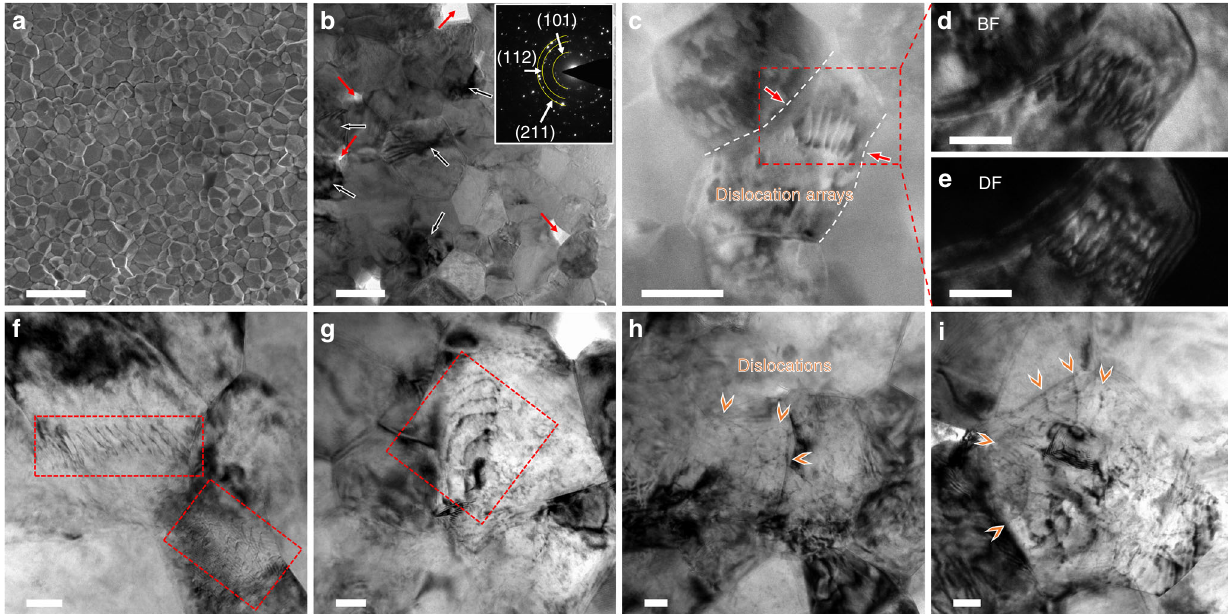
Fig. 1 Microstructure of fl ash-sintered 3YSZ. a SEM images of the unpolished fl ash-sintered 3YSZ. The average particle size is ~1 μ m. Scale bar, 3 μ m. b Bright- fi eld TEM micrograph showing subgrains with grain boundaries and defects generated during fl ash sintering (labeled by black arrows), and nanopores (~1.4%) (indicated by red arrows). The inserted SAD pattern shows diffraction rings. Scale bar, 200 nm. c A STEM micrograph showing a dislocation array inside a grain in the fl ash-sintered 3YSZ. The dislocation array was generated in a bottleneck region of the grain as indicated by red arrows. Scale bar, 100 nm. d , e Bright- fi eld (BF) and dark- fi eld (DF) TEM micrographs showing the dislocation array in the boxed region in c . Scale bar, 50 nm. f – i Numerous BF TEM images of the fl ash-sintered 3YSZ showing the existence of dislocations and dislocation arrays in grains. Scale bar, 50